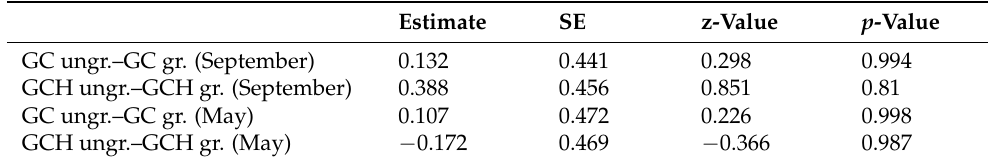
Table A25. Differences in species richness of agrotopic carabid beetles, comparing the grazed pastures and ungrazed strips of the grass–clover (GC) and the grass–clover herbs (GCH) in May/June and September.